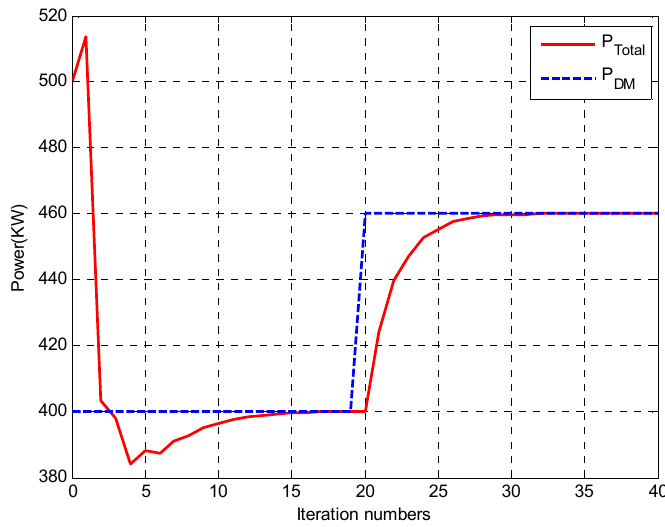
Figure 11. Power mismatch of the multi-period in the AC/DC hybrid microgrid.